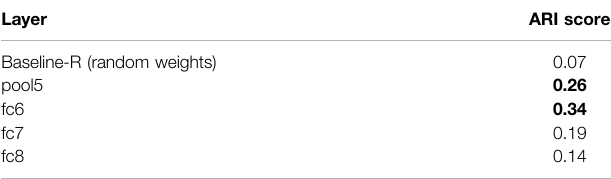
Best results presented in